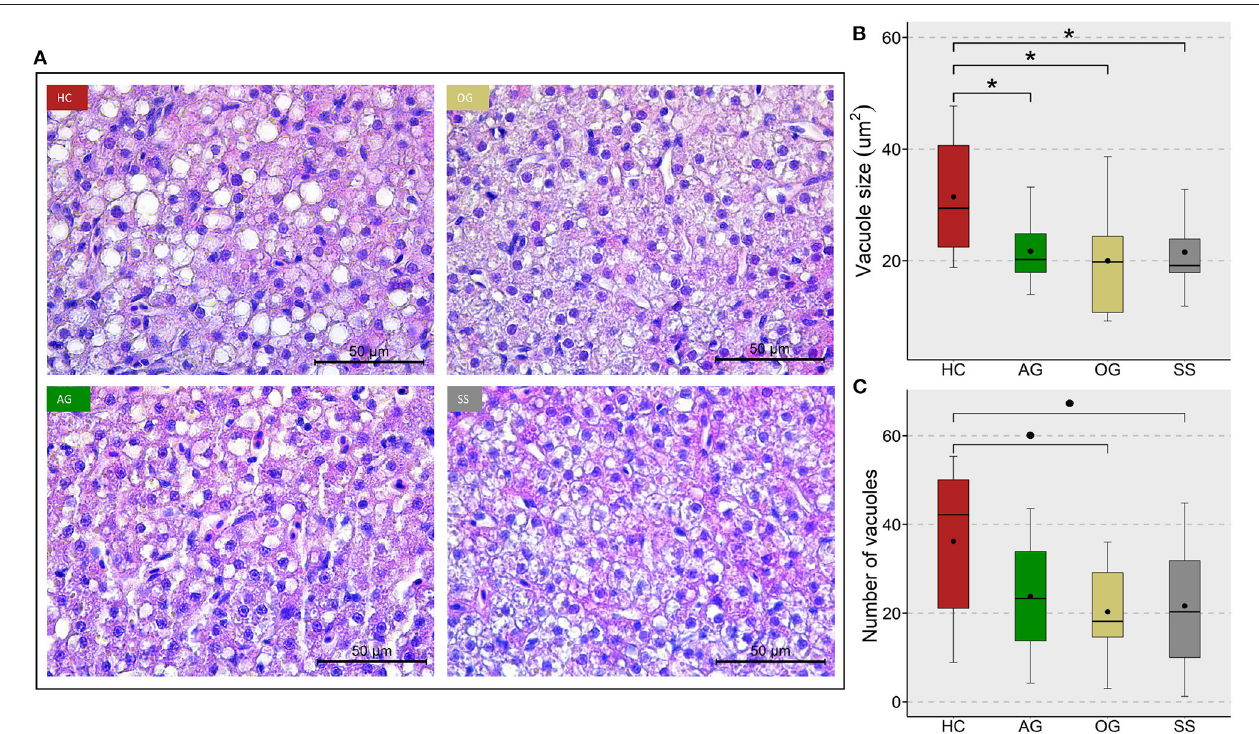
FIGURE 9 | Lipid accumulation in the liver of zebrafish fed four experimental diets. (A) Representative images of the liver of zebrafish. Scale bar = 50 µ m. Boxplots show average size (B) and average number (C) of vacuoles in the liver of fish fed high cholesterol (HC) diet or HC diet supplemented with either algal glucan (AG) or oat glucan (OG) or simvastatin (SS), for a period of 12 weeks. Black dots inside each box indicate the mean values of the corresponding groups. * indicates p < 0.05 and • indicates p < 0.1. Each treatment group consisted of eight biological